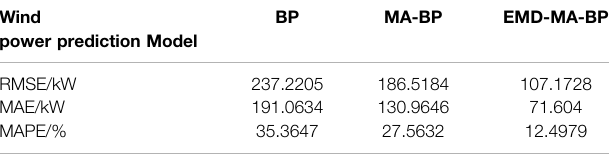
TABLE 2 | Average prediction error of each prediction